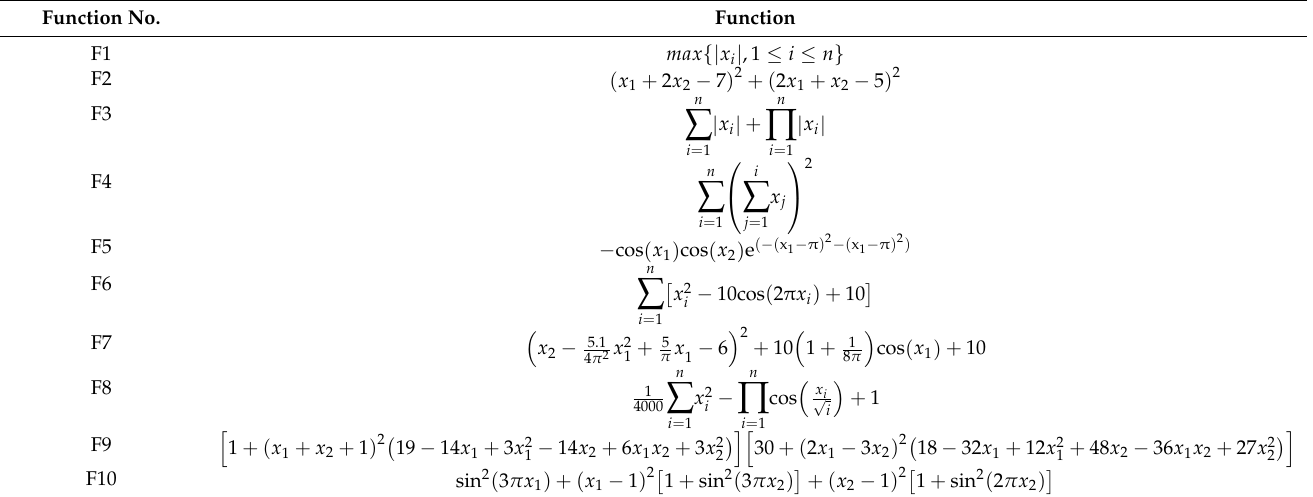
Table A2. Mathematical functions of benchmark